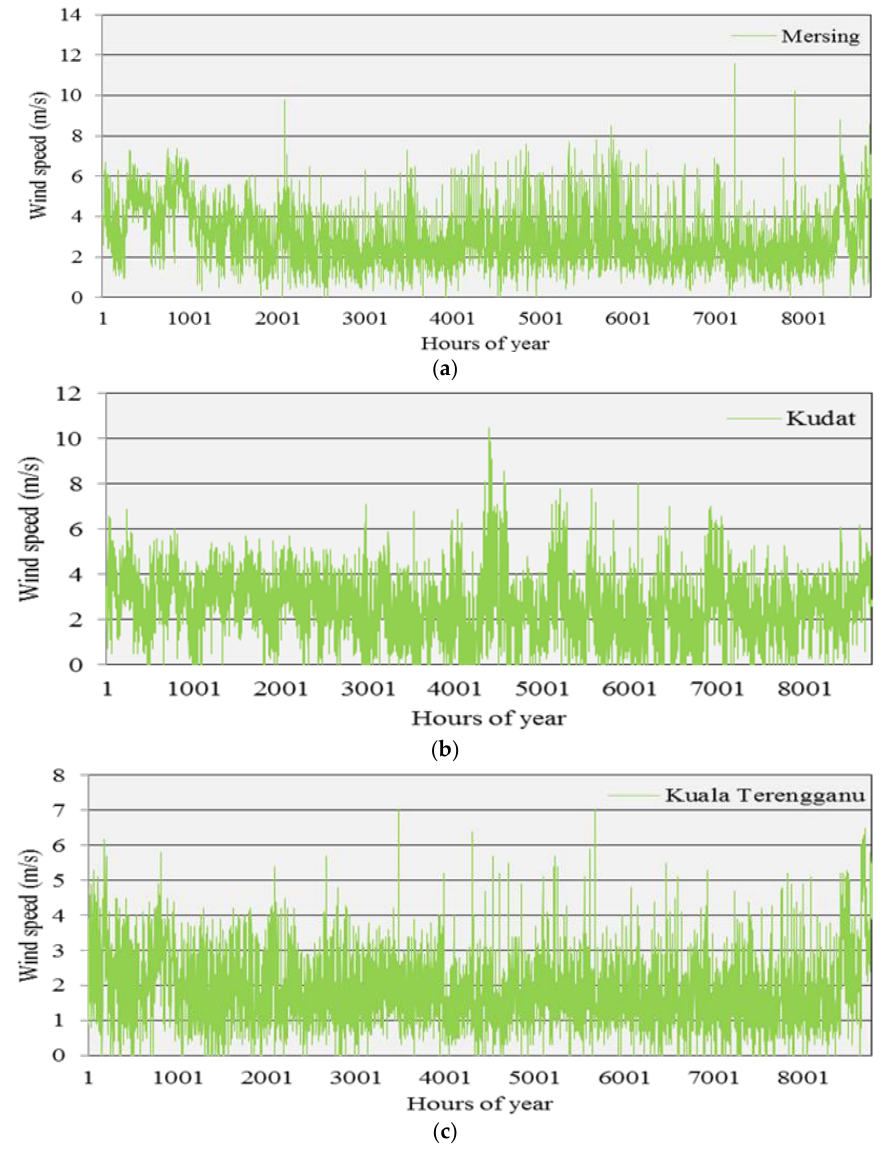
Figure 4. Hourly mean wind speed variation at ( a ) Mersing; ( b ) Kudat; and ( c ) Kuala Terengganu throughout the year 2015.